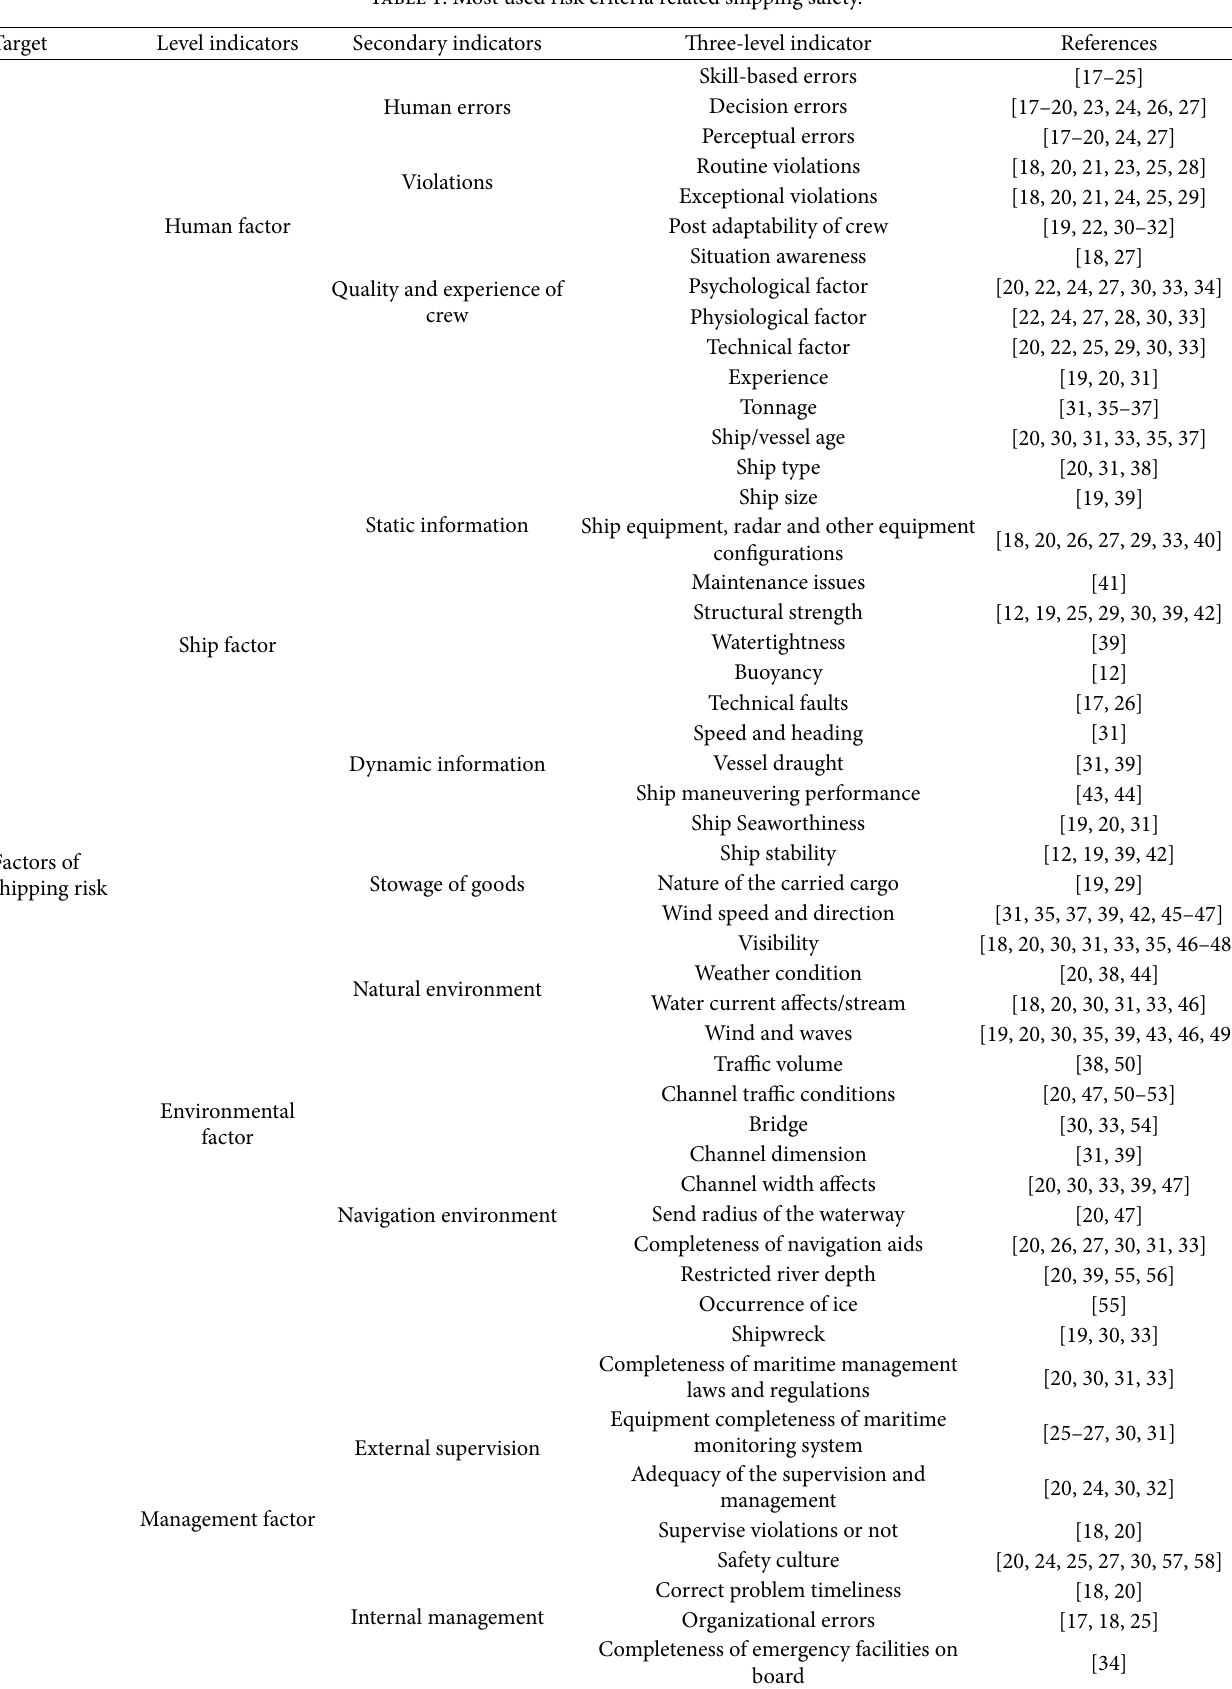
Table 1: Most used risk criteria related shipping